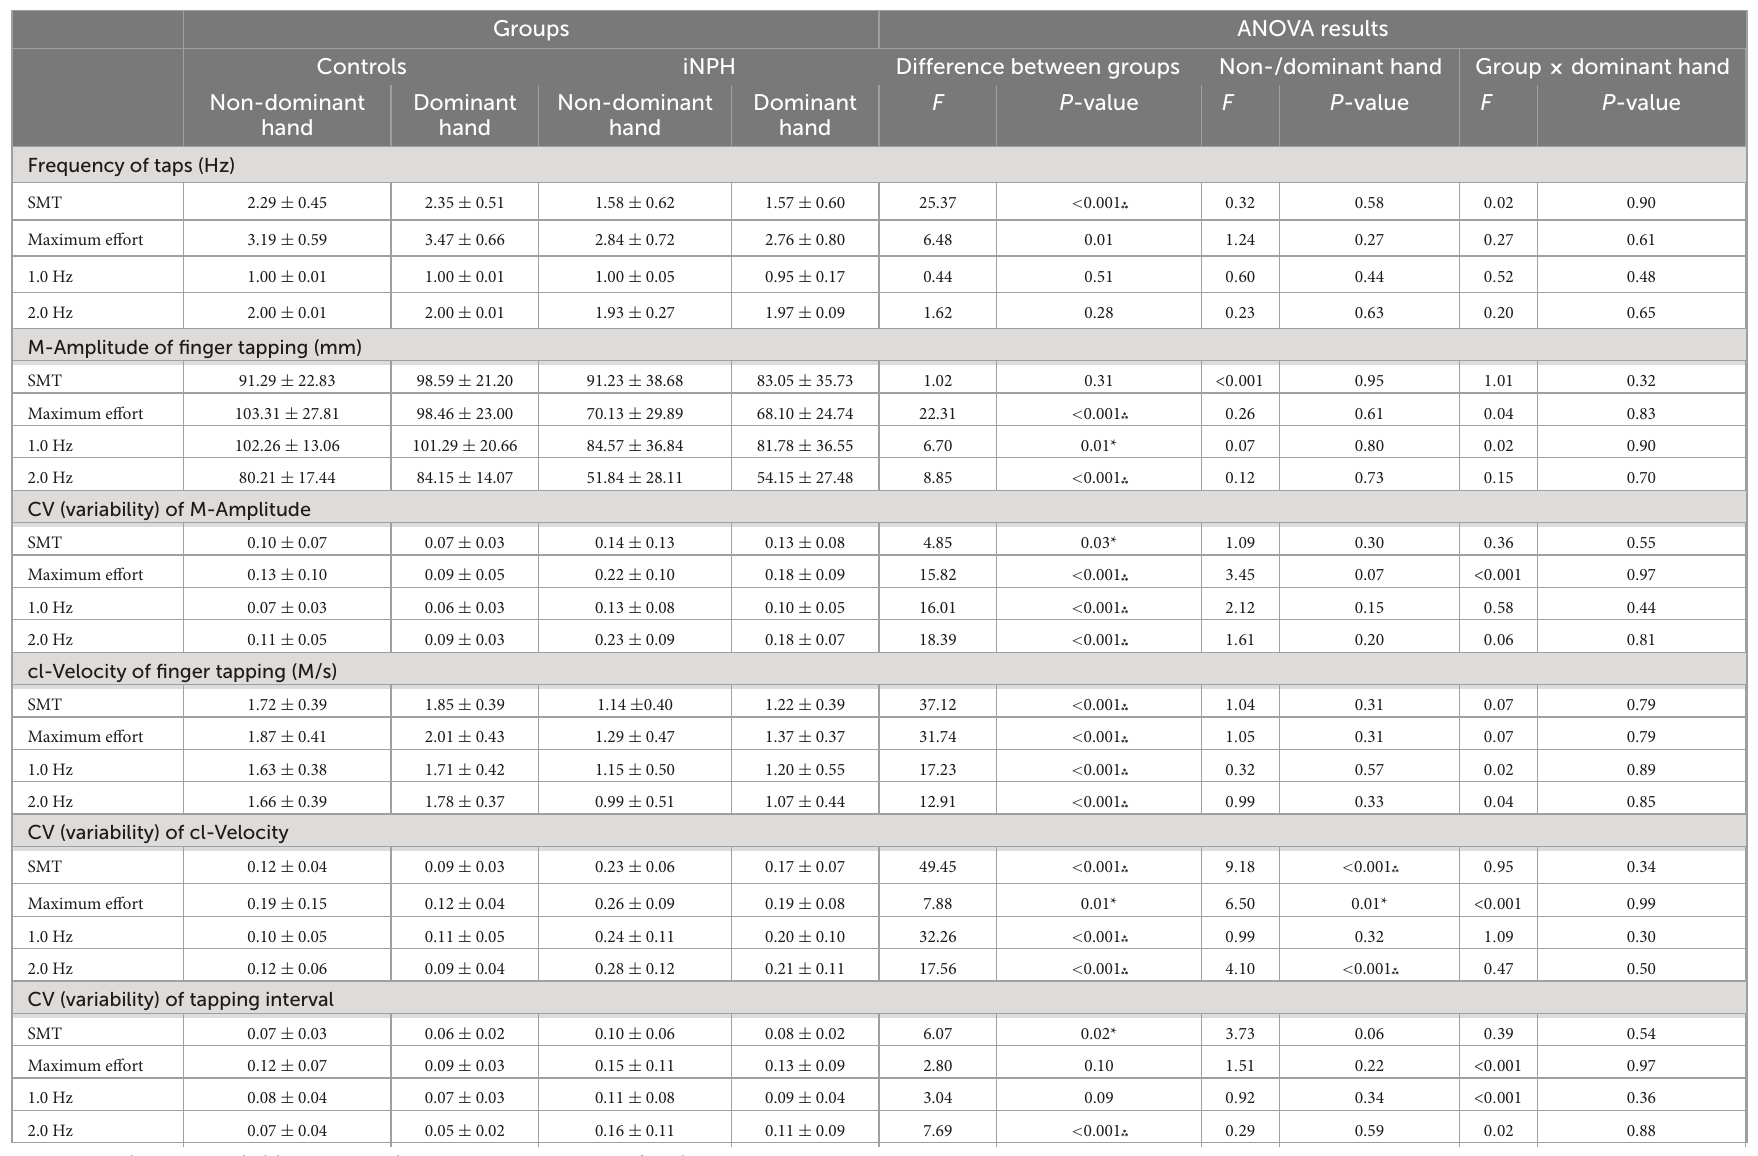
TABLE 2 Comparison of F-T parameters in controls and patients with definite iNPH. Groups ANOVA results Controls iNPH Difference between groups Non-/dominant hand Group × dominant